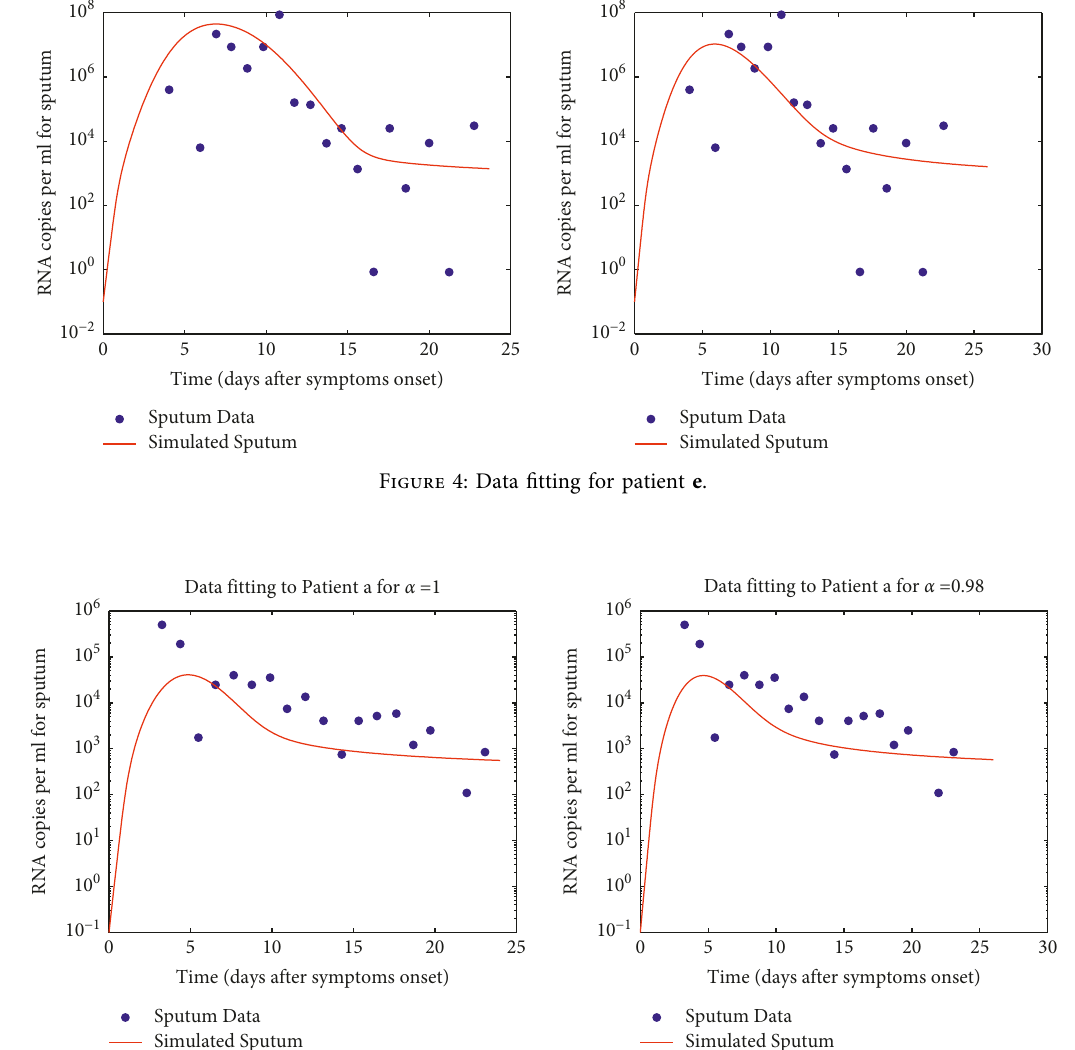
Figure 3: Data fitting for patient d . Data fitting to Patient a for α =1 Data fitting to Patient a for α =0.98